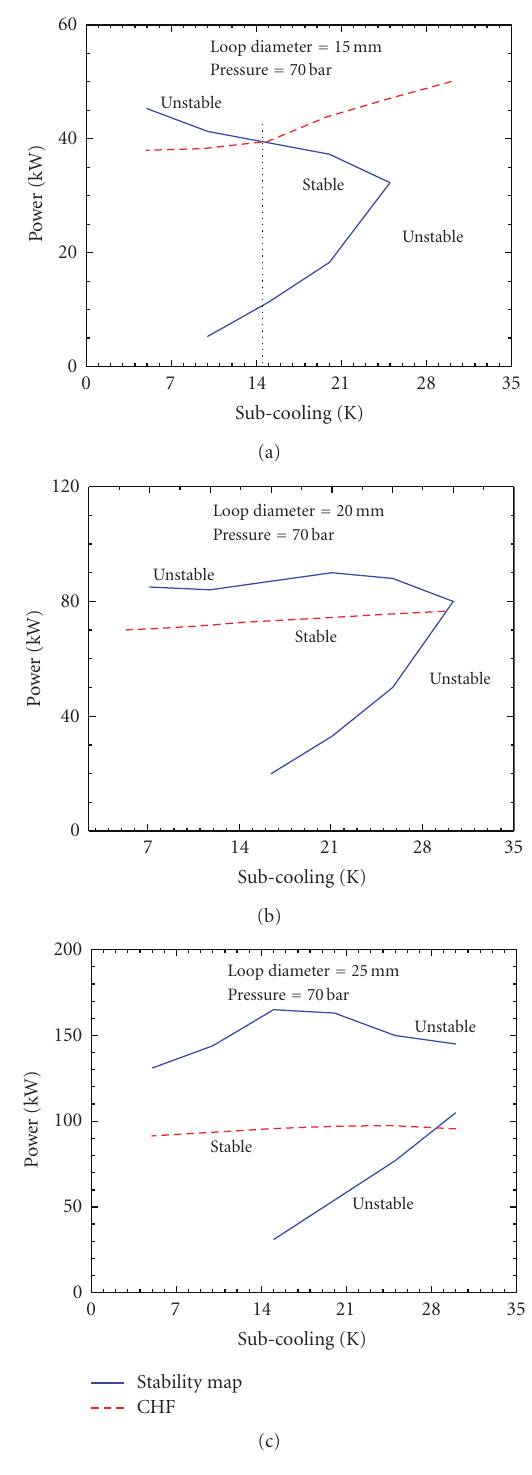
Figure 23: CHF controlled designs and loop